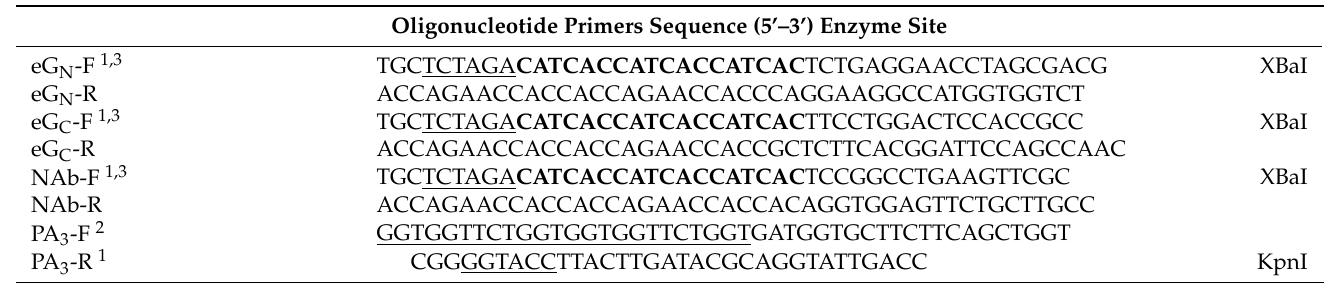
Table 1. Oligonucleotide primers used in this study. Oligonucleotide Primers Sequence (5’–3’) Enzyme